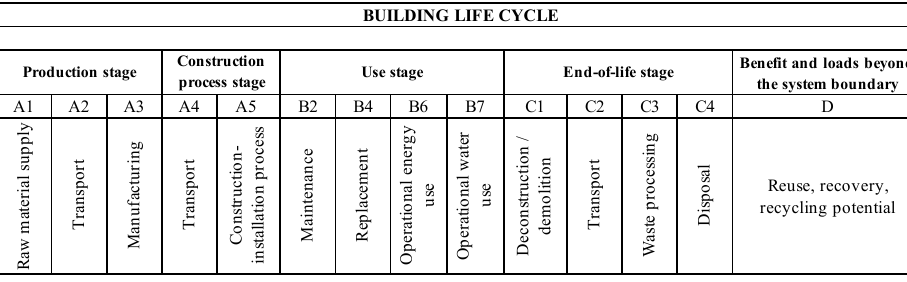
Figure 2. Different life stages of timber and steel materials used in the LCA.